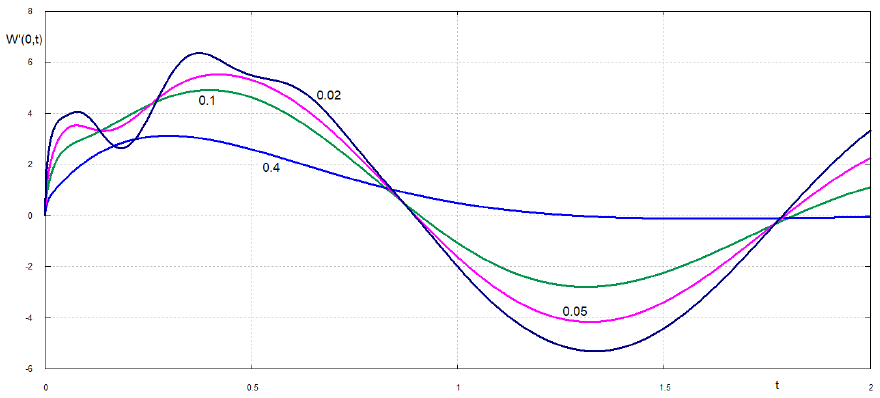
Figure 5. Dimensionless velocity of the plate edge W t ( 0, t ) after the plate breaking for small values of the dimensionless retardation time ˜ τ =